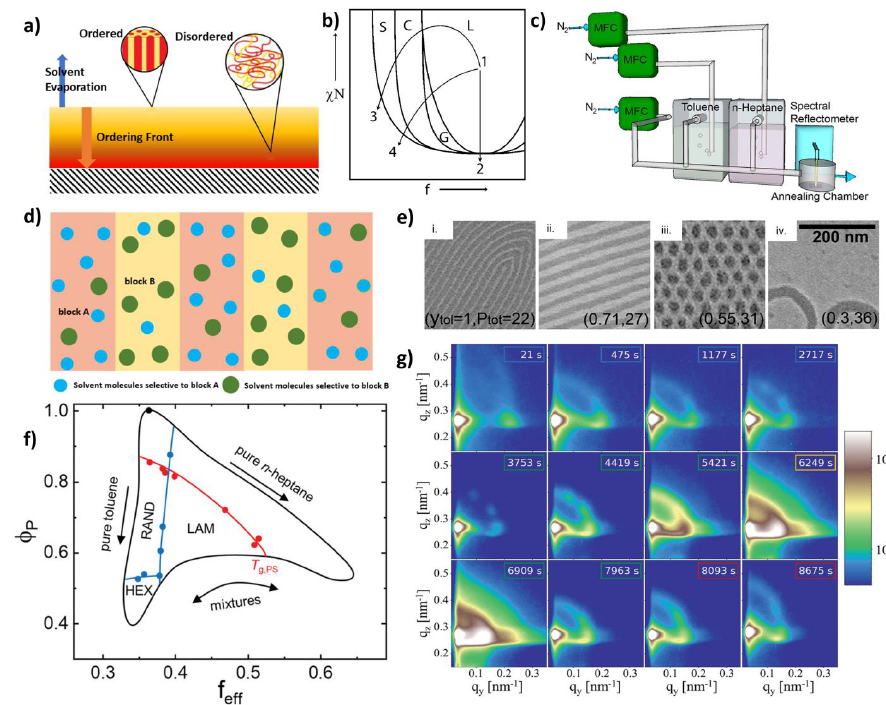
Figure 2. ( a ) Schematic diagram of the solvent evaporation and ordering in a thin block copolymer film, [38] . ( b ) Diblock copolymer phase diagram showing the effect of swelling in different solvents. 1 – 2: swelling in a nonselective solvent; 1 – 3, 1 – 4: swelling in a highly selective and a partially selec- tive solvent [42] . ( c ) Continuous flow annealing with the mixed solvent vapors [43] . ( d ) Schematic representation of the solvent activity inside the thin film, based on the polymer-solvent interaction parameter. ( e ) (i, ii, iii, and iv) Morphologies observed in toluene and n-heptane solvent mixture, depending on the partial pressure and volume fraction of toluene (given in parentheses) [43] . ( f ) Diagram of the states representing different process pathways [44] . ( g ) GISAXS images obtained in the stepwise solvent vapor annealing [44] . Adapted with permission from references [38,44] .